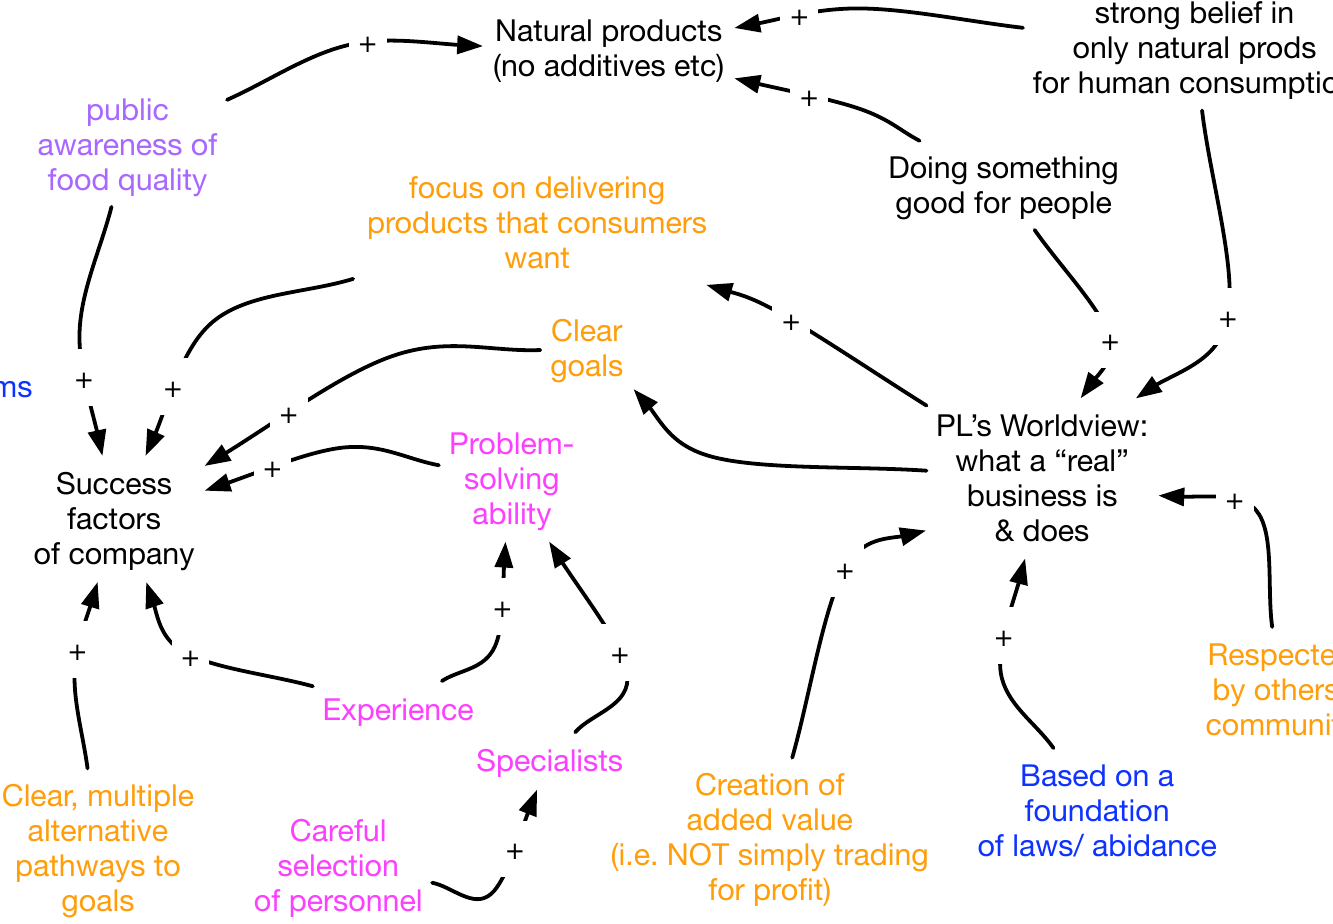
Figure A2:17. Case Berries, Theme: Leadership,